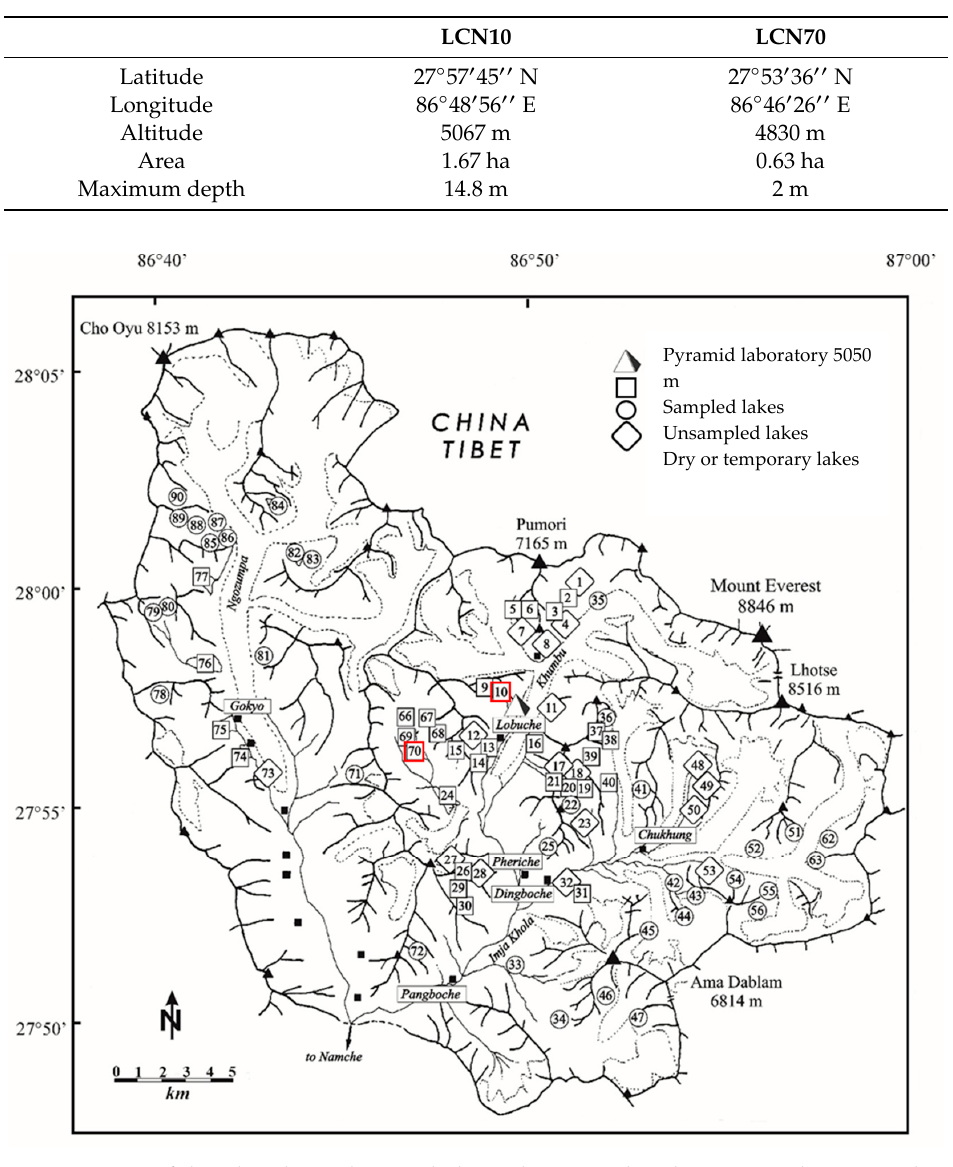
Figure 1. A map of the Khumbu and Imja Khola catchment within the Sagarmatha National Park, Nepal in which are highlighted all lakes sampled in the framework of the EV-K2-CNR project since 1987 (G.A. Tartari, pers. comm.). Black triangles refer the mountain peaks; black squares refer to localities. Red squares highlight the study sites.